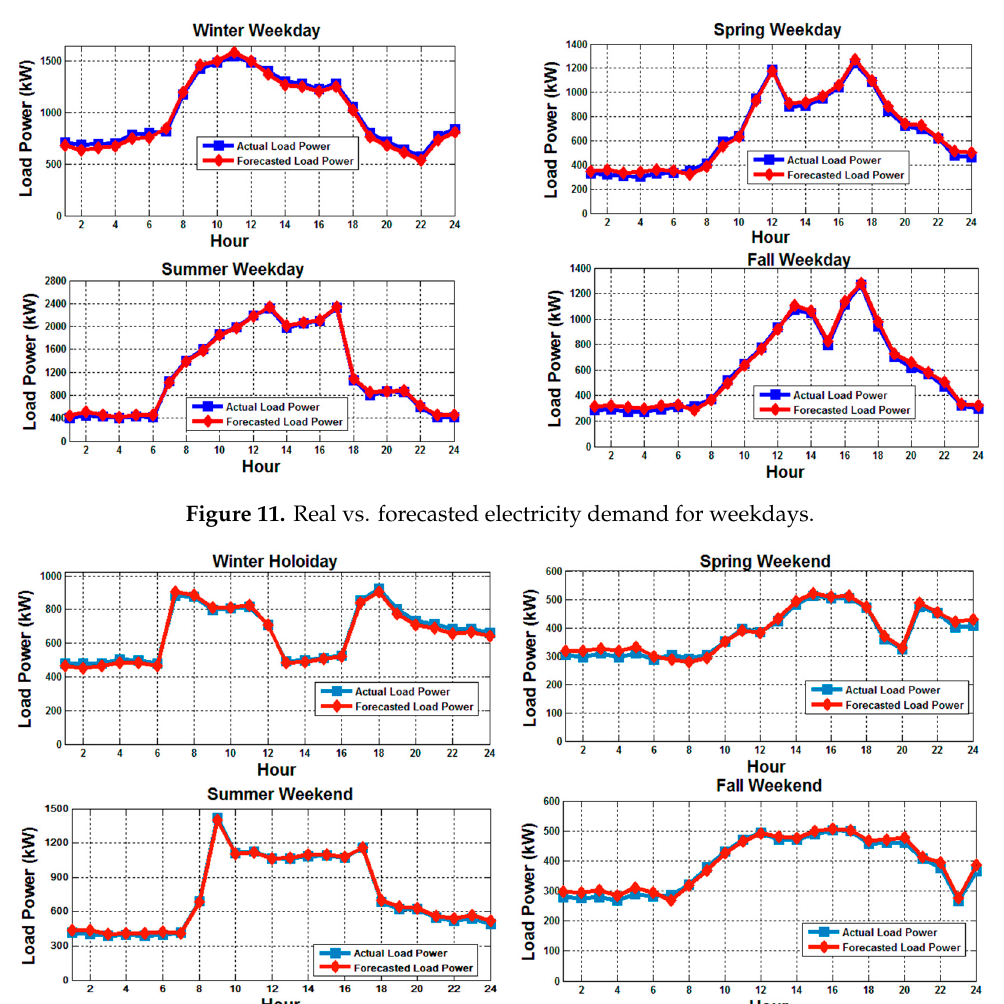
Figure 12. Real vs. forecasted electricity demand for weekends/holidays.